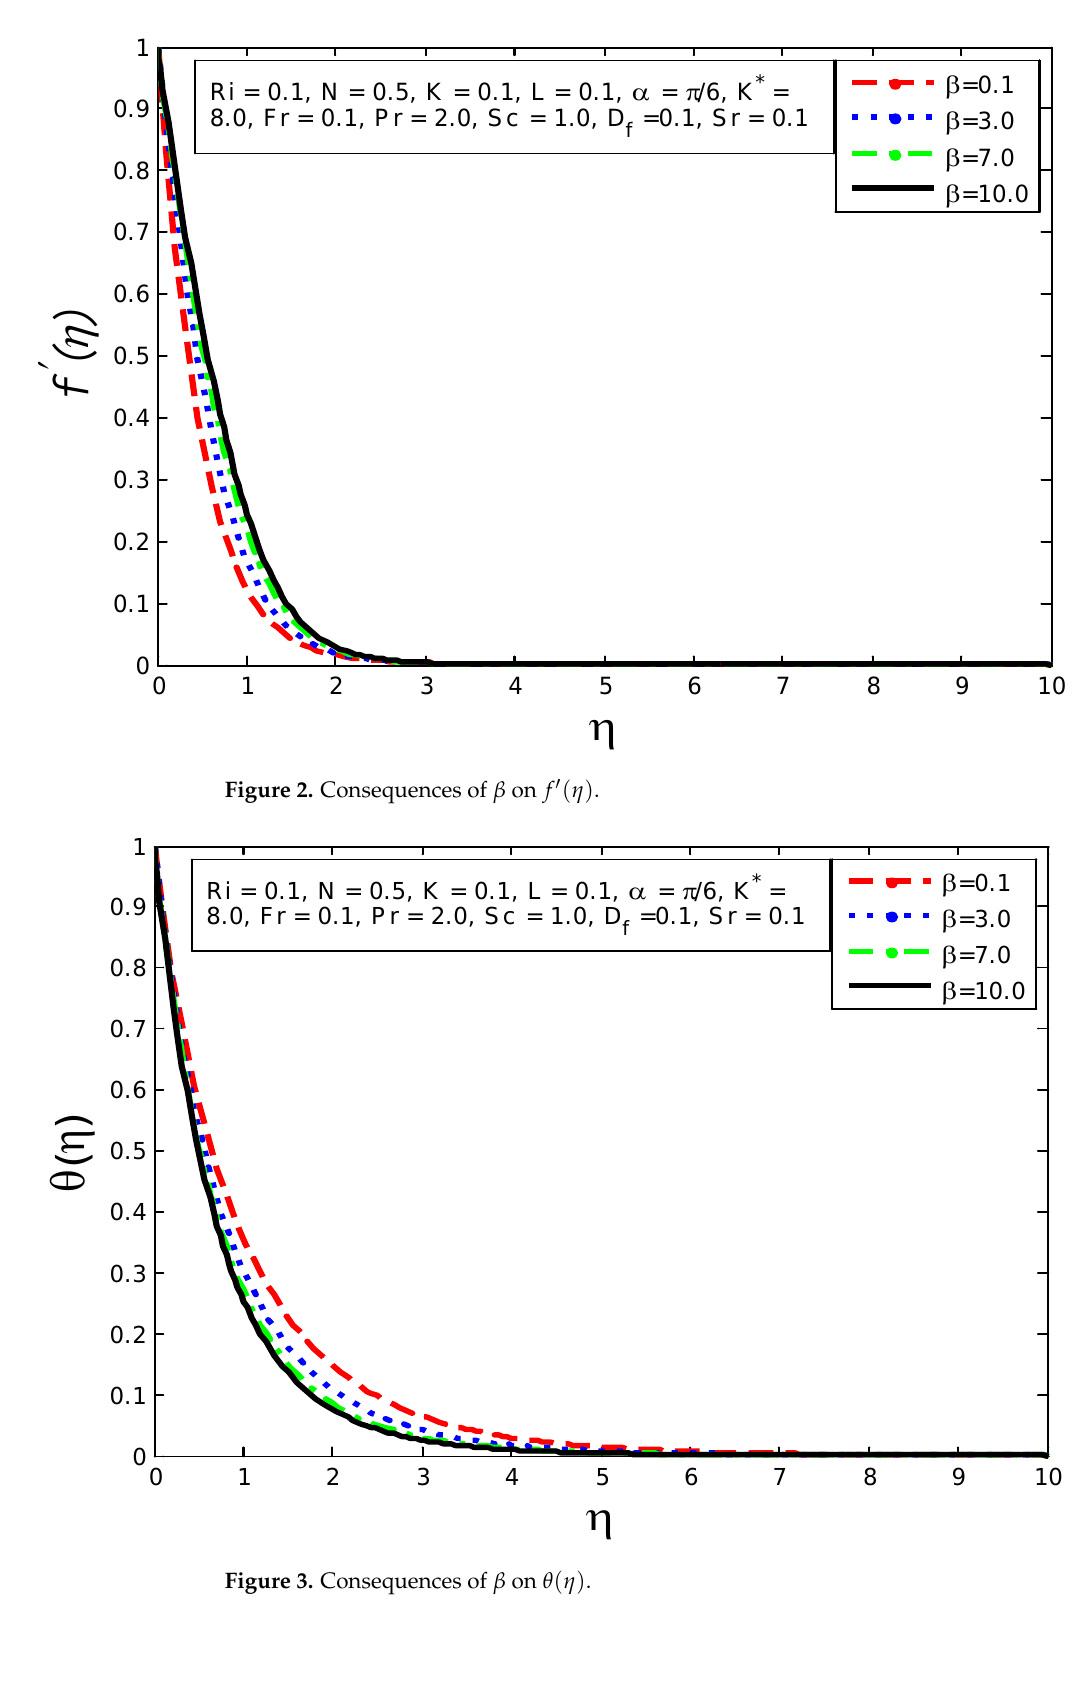
Figure 4. Consequences of 𝛽𝛽 on 𝜙𝜙 ( 𝜂𝜂 ) .